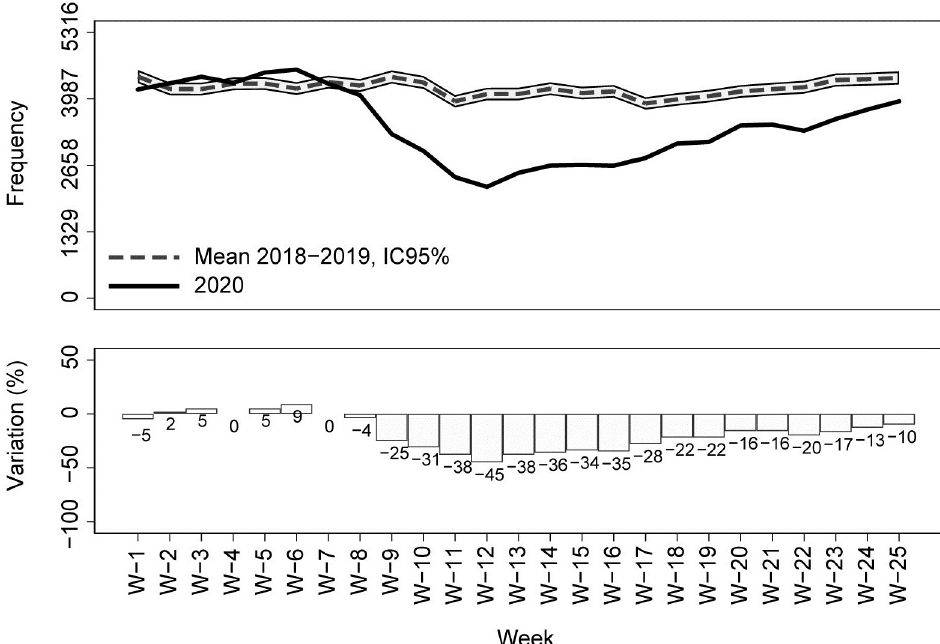
Fig 3. Emergency department admissions in Tuscany Region by week (year 2020 vs 2018–19); percentage changes and 95% CIs.